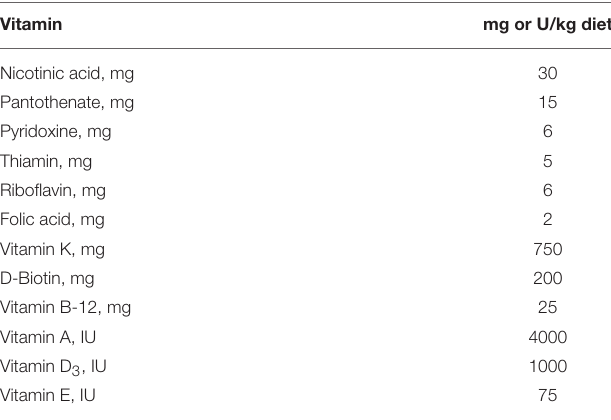
TABLE 2 | Composition of vitamin